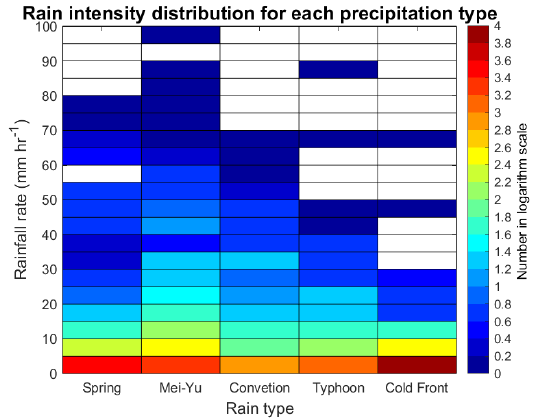
Figure 3. The distribution of rainfall intensities calculated from 6-min raindrop size distributions (RSDs) for different precipitation types (spring rain, Mei-Yu, convection, typhoon, and cold front).